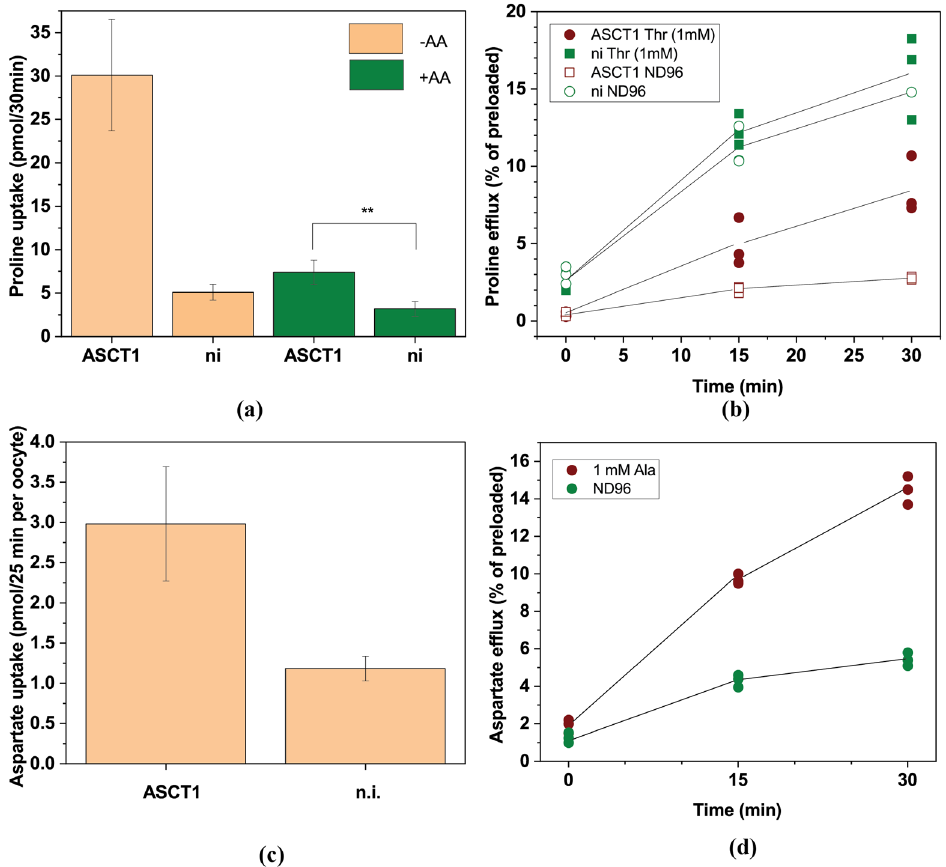
Figure 8. Analysis of ASCT1-mediated proline and aspartate transport. ( a ) Uptake of 0.1 mM [ 14 C]proline was measured after 30 min in the presence and absence of an unlabelled amino acid mix (0.1 mM each) in oocytes expressing ASCT1 or in non-injected oocytes. ( b ) Oocytes expressing ASCT1 or non-injected oocytes were preincubated with 0.1 mM [ 14 C]proline for 1h. After washing, oocytes were incubated in ND96 in the presence (+Thr) and absence ( − Thr) of 1 mM threonine and supernatant samples were analysed for radiolabelled proline after 15 and 30 min. Due to the difference in preloading, efflux is shown as % of preloaded [ 14 C]proline. ( c ) Uptake of 0.025 mM [ 14 C]aspartate was measured after 25 min in oocytes expressing ASCT1 or in non-injected oocytes. ( d ) Oocytes expressing ASCT1 were preincubated with 0.025 mM [ 14 C]aspartate for 2h. After washing, oocytes were incubated in ND96 in the presence (+Ala) and absence (ND96) of 1 mM alanine and supernatant samples were analysed for radiolabelled aspartate after 15 and 30 min. Due to the difference in preloading, efflux is shown as % of preloaded [ 14 C]aspartate.